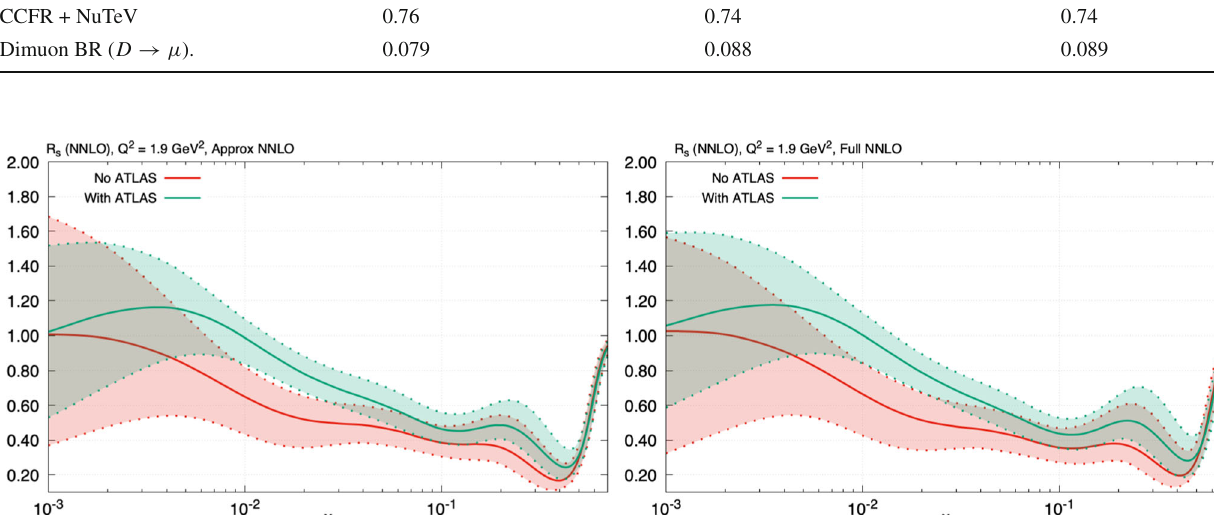
data are shown in the left and right figures, respectively. In both cases the result of the global fit including and excluding the ATLAS 7 and 8 TeV precision W , Z data are